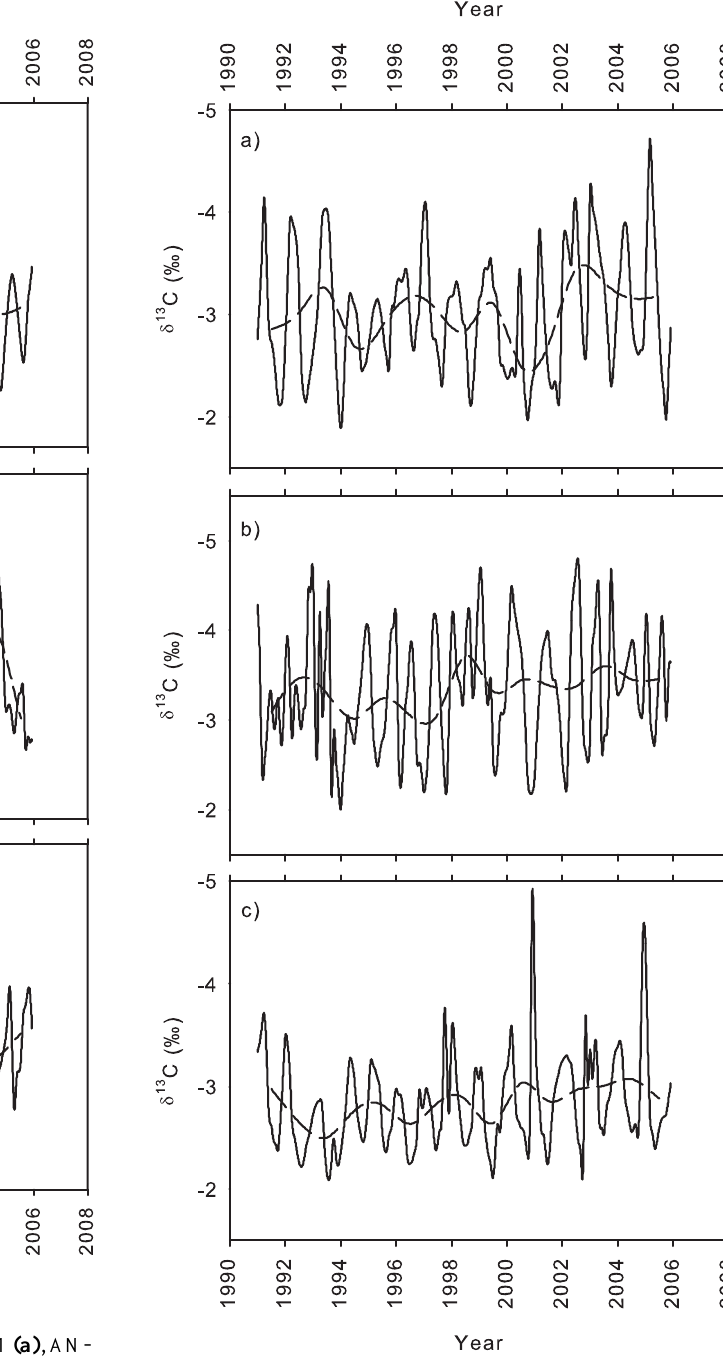
Fig. A4. The δ 13 C of coral cores MAS1 (a) , ANDRA (b) and IFAHO (c) relative to V-PDB. The annual average (dashed line) val- ues were calculated by averaging the months January to December for each of the